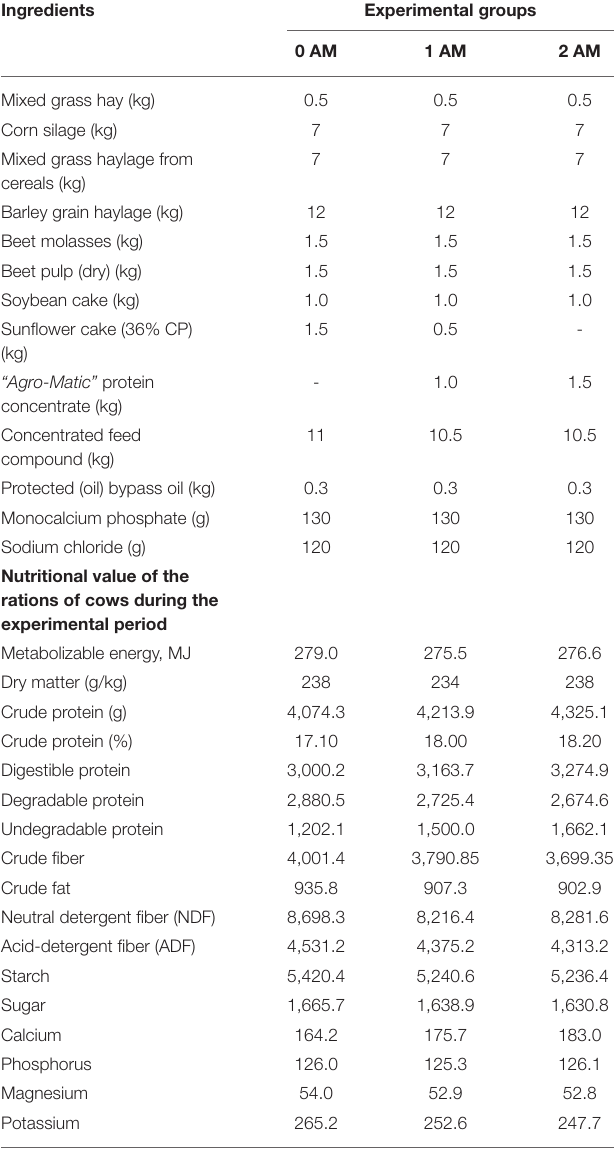
TABLE 1 | Basal ration composition and the nutritional value of the rations of cows during the experimental